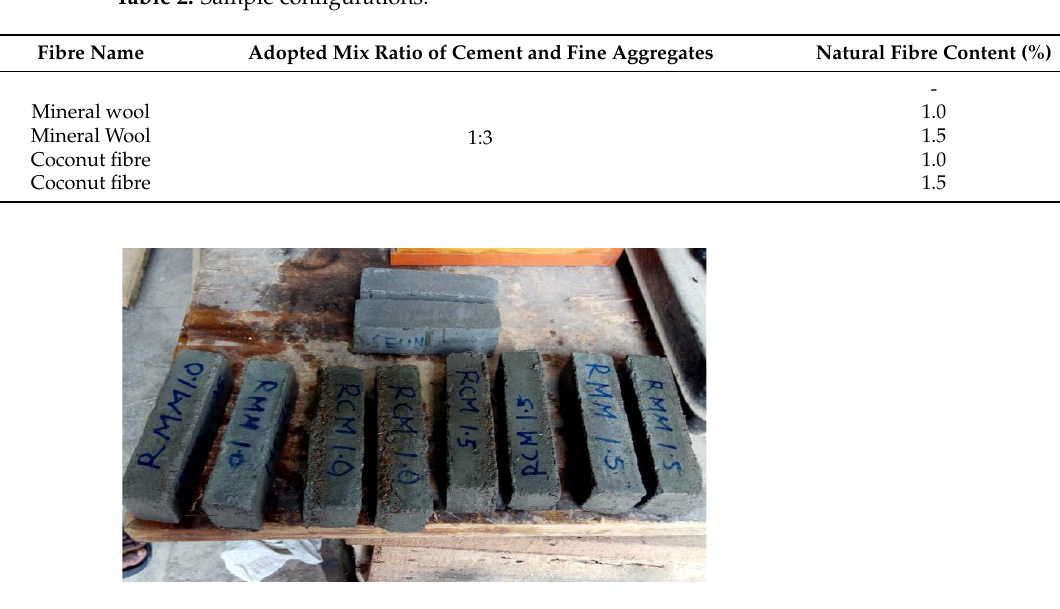
Figure 3. Hardened mortar samples.